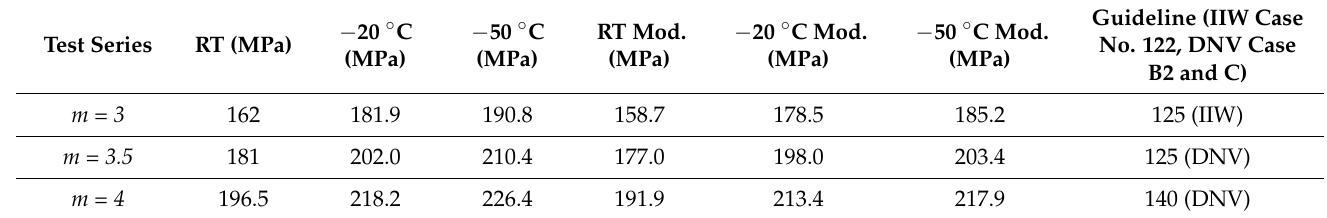
Table 3. FAT-class values for test series RT, − 20 ◦ C, and − 50 ◦ C, and for test series with modified stress range values with different fixed slopes and FAT-class values from guidelines